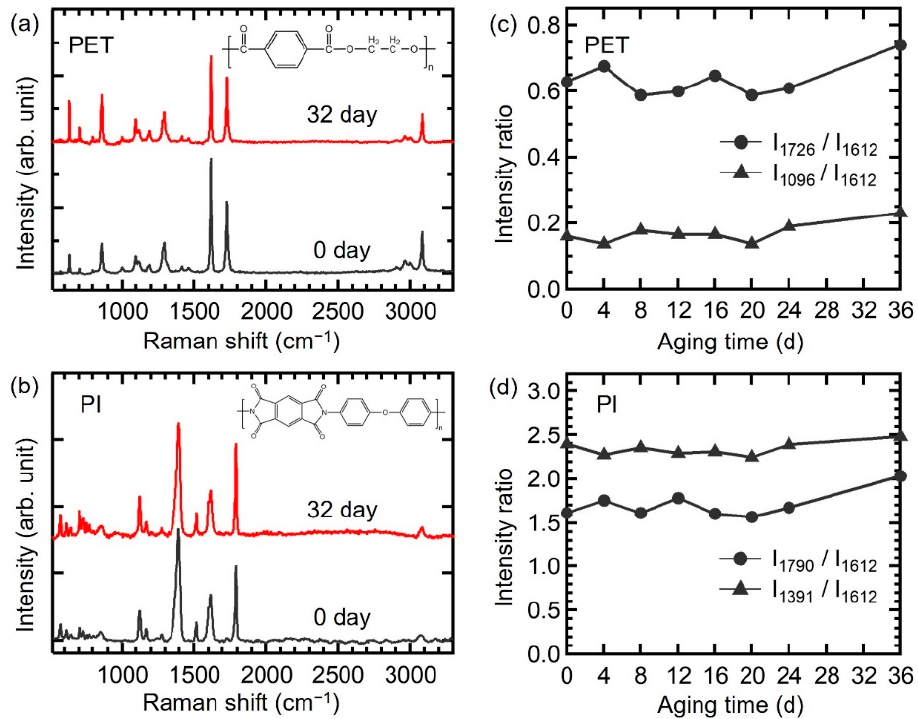
Figure 2. The Raman spectra of ( a ) raw PET and ( b ) PI films with their corresponding aging films. Influence of aging time on the relative intensity ratio of the functional groups on PET ( c ) and PI ( d ) films. The inserts in the Raman spectra are the corresponding structure diagrams of PET and PI films.